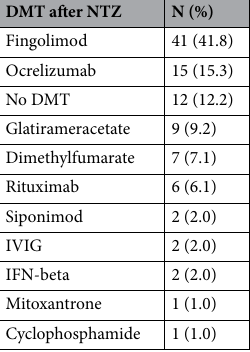
Table 3. First DMT after NTZ. For 98 patients data about further treatment strategy after discontinuation of NTZ were available. DMT disease modifying treatment, IVIG intravenous immunoglobulins, IFN